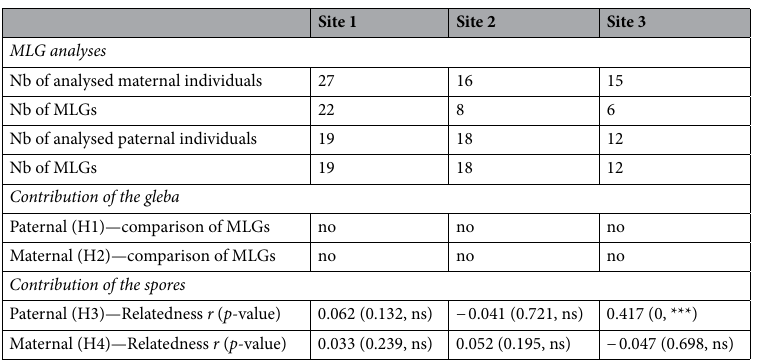
Table 2. Number of T. melanosporum fruitbodies included for genotyping and genetic analyses testing the contribution of the inoculum to the harvested fruitbodies (see the four hypotheses in Fig. 1c). *** p -values < 5e- 4 after Bonferroni